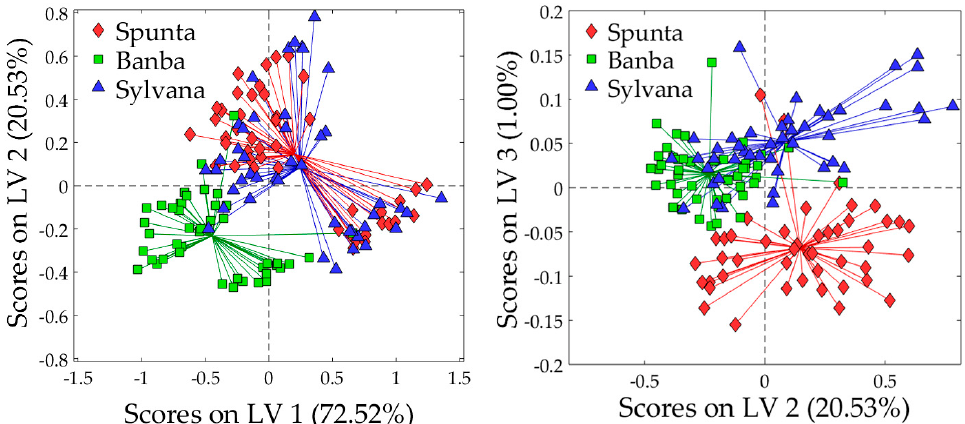
Figure 7. Classification of potato tubers into 3 commercial potato cultivars (Spunta, Banba, and Sylvana) that were stored for 0, 2.5, and 5 months at 5 ◦ C based on the scores of LV1, LV2, and LV3 after the partial least squares discriminant analyses on the data from specific wavelength regions that were extracted with the genetic algorithm as a feature extraction technique of the spectra that were captured externally on the skin of the tubers.